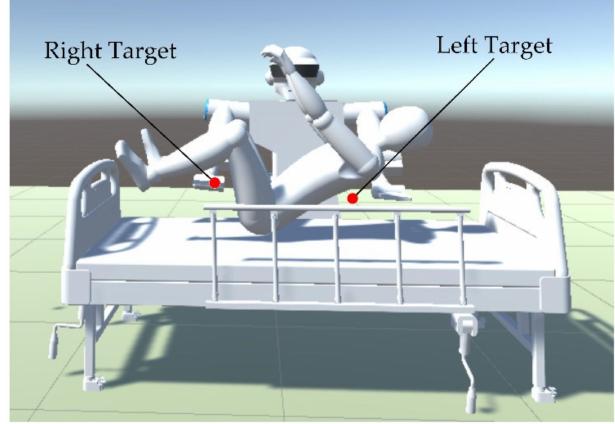
Figure 6. The target setting diagram.